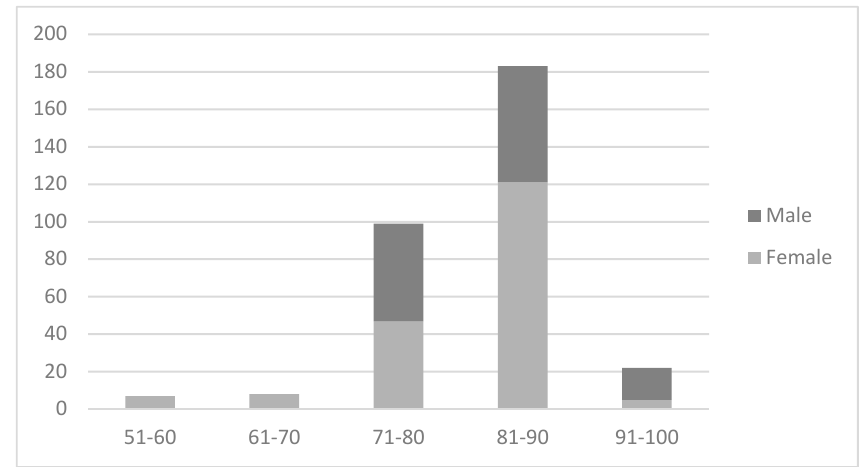
Figure 2. Hours in A&E by age and gender.